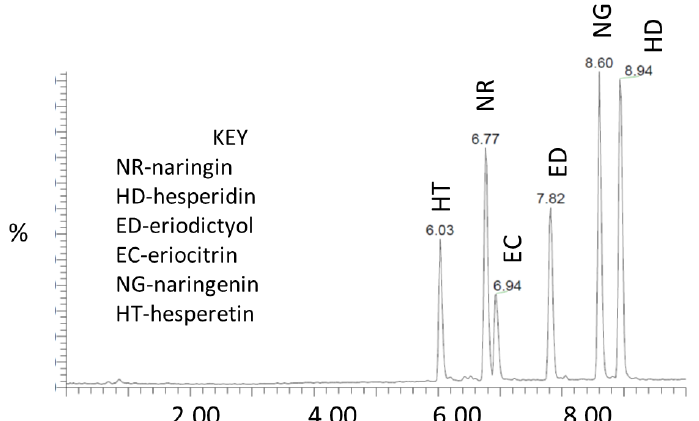
Figure 1. Chromatograms of the citrus bioflavonoids’ standard peaks. ER, eriocitrin; ED, eriodictyol; NR, naringin; NG, naringenin; HD, hesperidin; HT, hesperetin. Examples of UPLC–MS/MS MRM chromatograms are presented in Figure 2. Supplement CBF-1 contained 15.7% bioflavonoids, dominated by hesperidin and rutin. By contrast, CBF-6 contained only 0.8% bioflavonoids, principally naringin and hesperidin. Both chromatograms demonstrated satisfactory resolution and peak shape with high sensitivity.